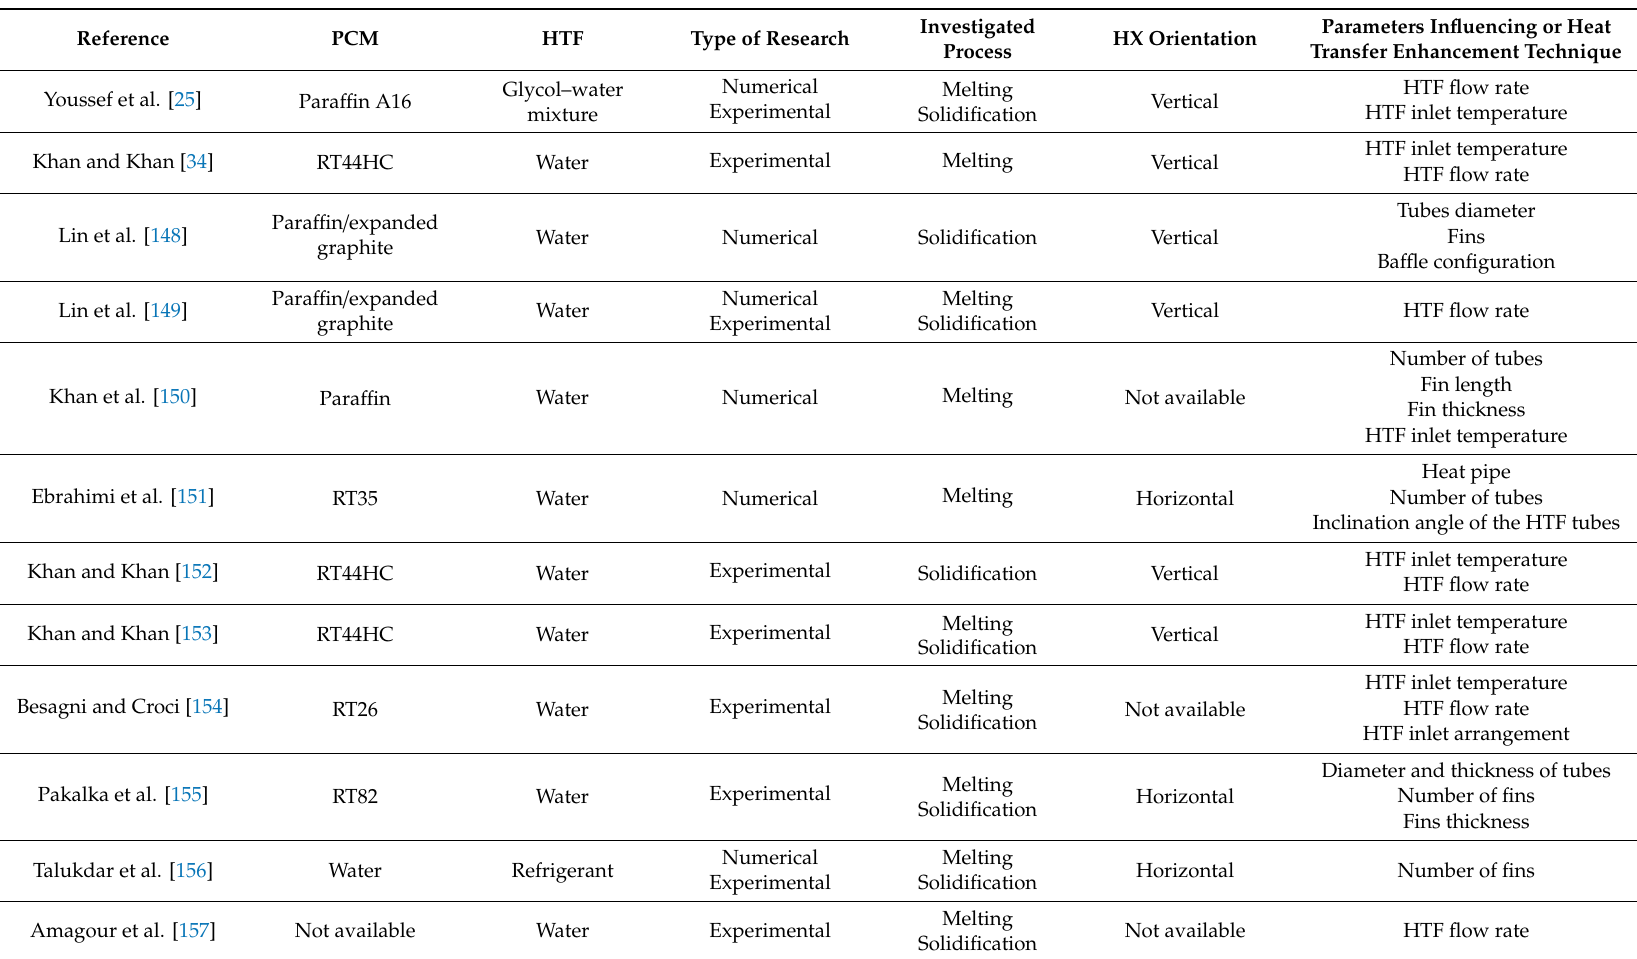
Table 9. Research on the other types of heat